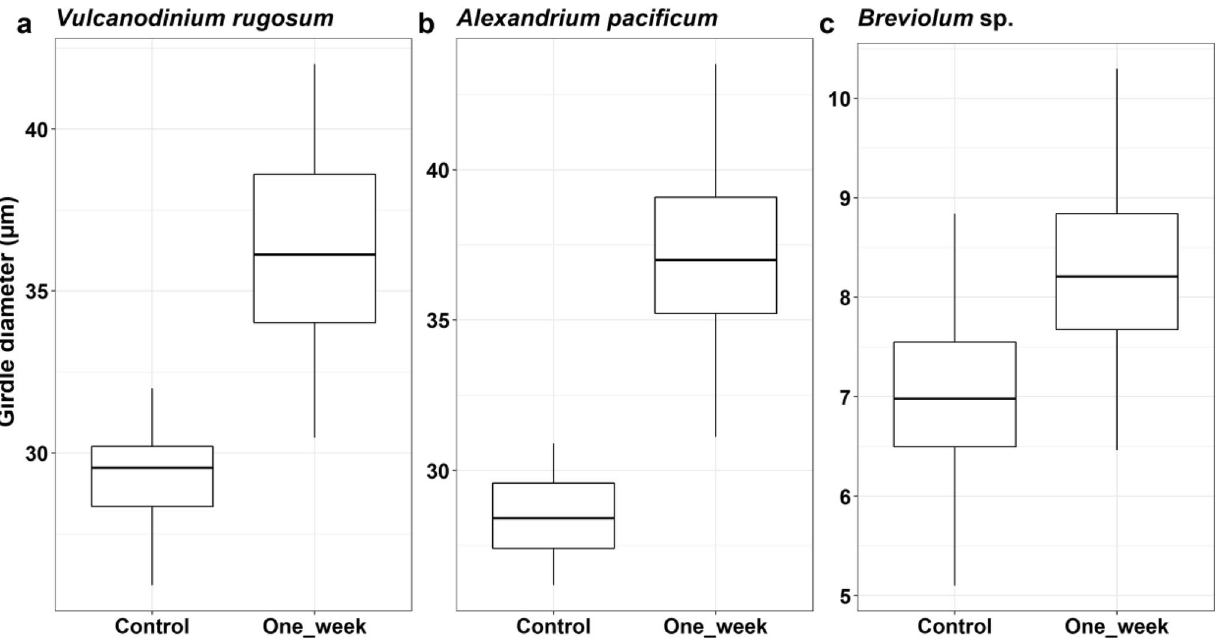
Figure 4. Changes in girdle size of each dinoflagellate species after one week of incubation with growth media without cryoprotectant agents (CPAs) compared to untreated cells (control). Results are shown for the preferred CPAs treatment for each species (n =